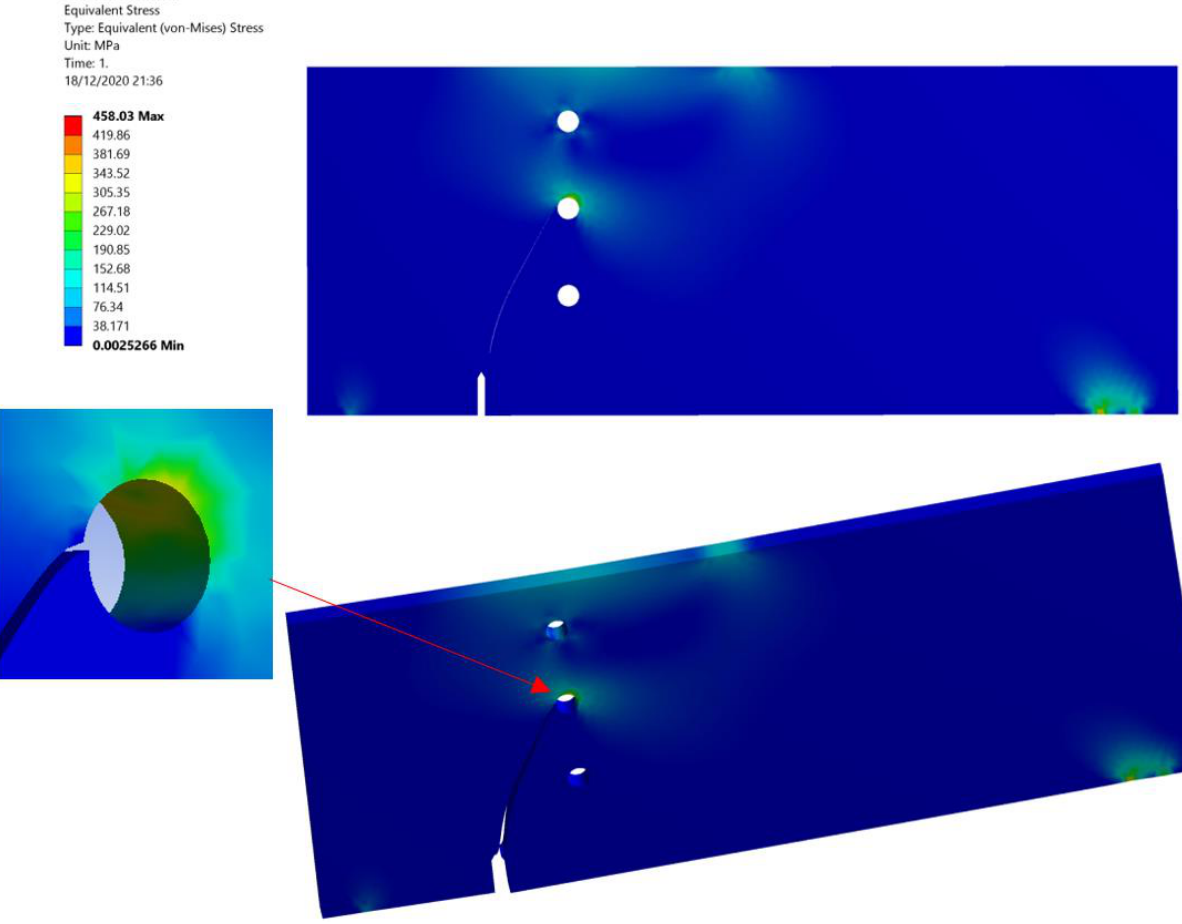
Figure 12. Equivalent Von-Mises stress distribution for specimen 3.